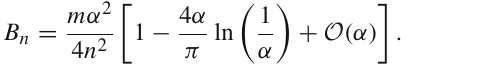
κ > 0 (colored solid lines) do not have any non-relativistic counterparts. Lower panel represents the spectrum for n ≥ 1 states and different values of κ = 0 , 1 , 2 , 3. The horizontal line λ = 2 ( α = 2 π ) indicates the maximal value of